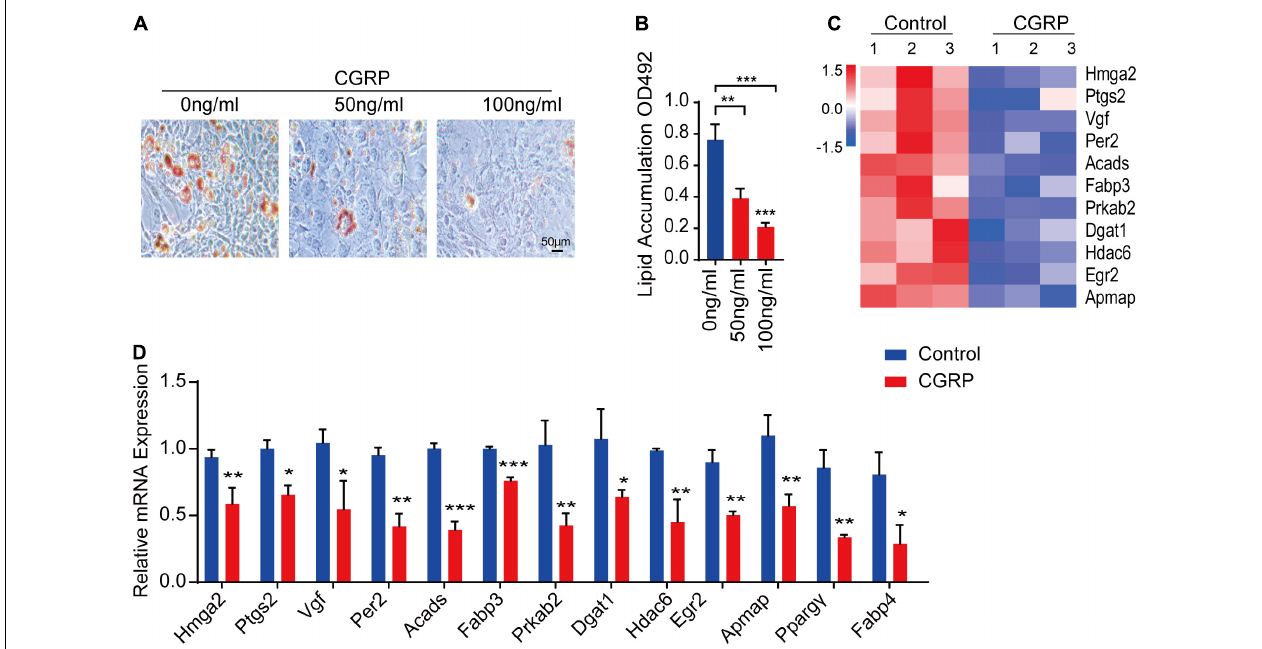
FIGURE 3 | CGRP inhibited the adipogenic differentiation of bone marrow-derived stem cells (BMSCs). (A) Representative images of Oil Red O staining and (B) quantitative analysis of lipid droplet formation in BMSCs treated with or without CGRP. (C) A heatmap of the mRNA-seq profile of BMSCs treated with or without CGRP. Fold change ≥ 2.0. (D) RT-qPCR analysis of gene expression levels in BMSCs treated with or without CGRP. Scale bar, 50 µ m. Data are presented as means ± SEM. * P < 0.05, ** P < 0.01,*** P < 0.001.